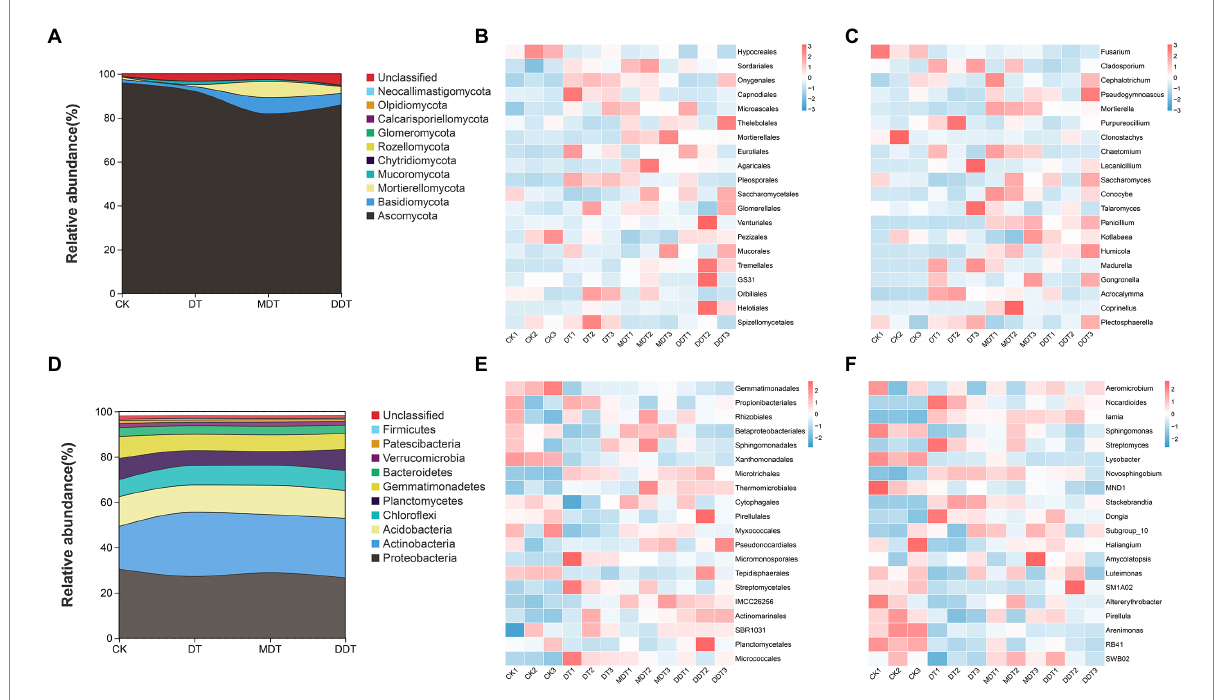
FIGURE 6 Phyla, order and genus horizontal community structure of rhizosphere soil fungi (A–C) and bacteria (D–F)